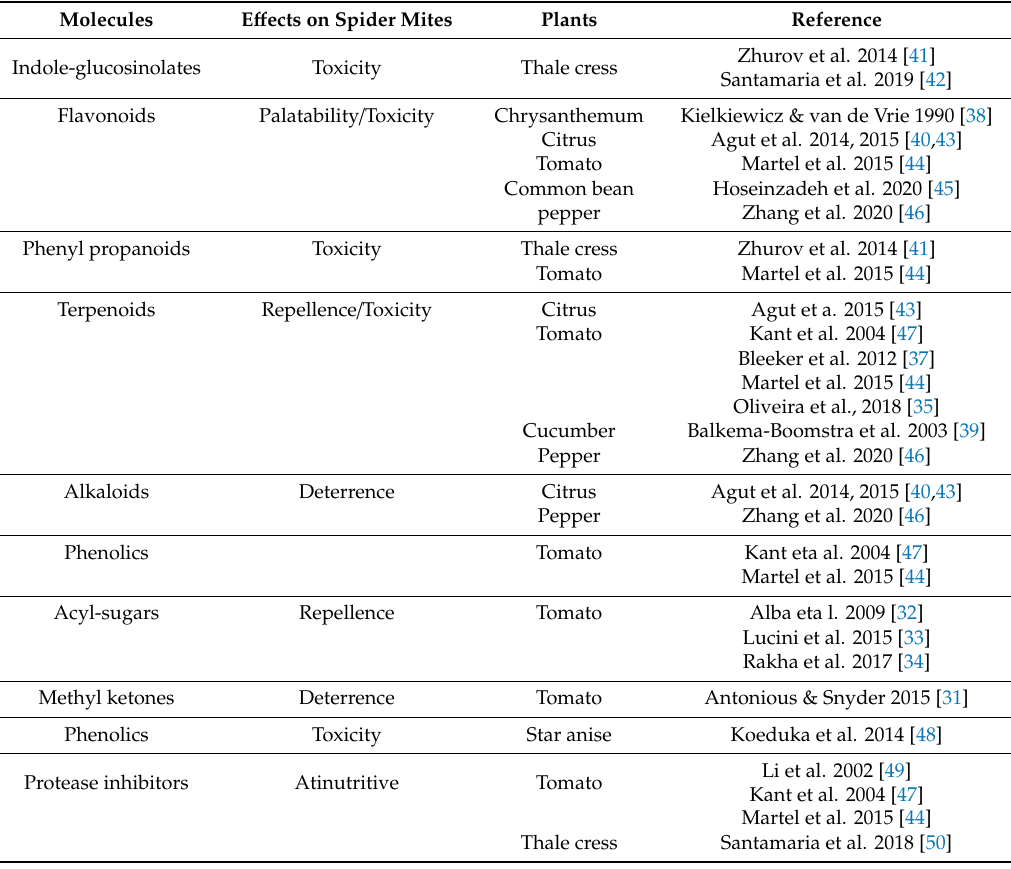
Table 1. Plant-derived molecules with defense properties directly targeted to T.